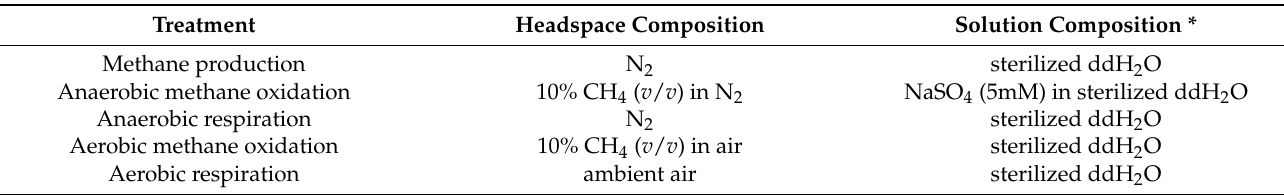
Table 2. Experimental